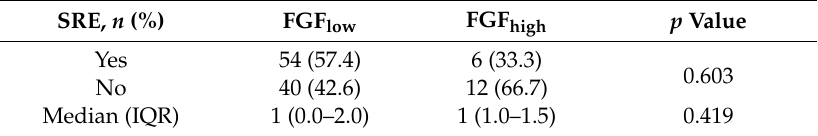
Figure 2. Kaplan-Meier TTSRE curves, according to FGF23 levels. High levels of serum FGRF23 were associated with shorter time to SREs (13.0 vs. 2.0 months, p = 0.04). P-value was calculated using log-rank test. Table 3. SRE occurrence by FGF group.